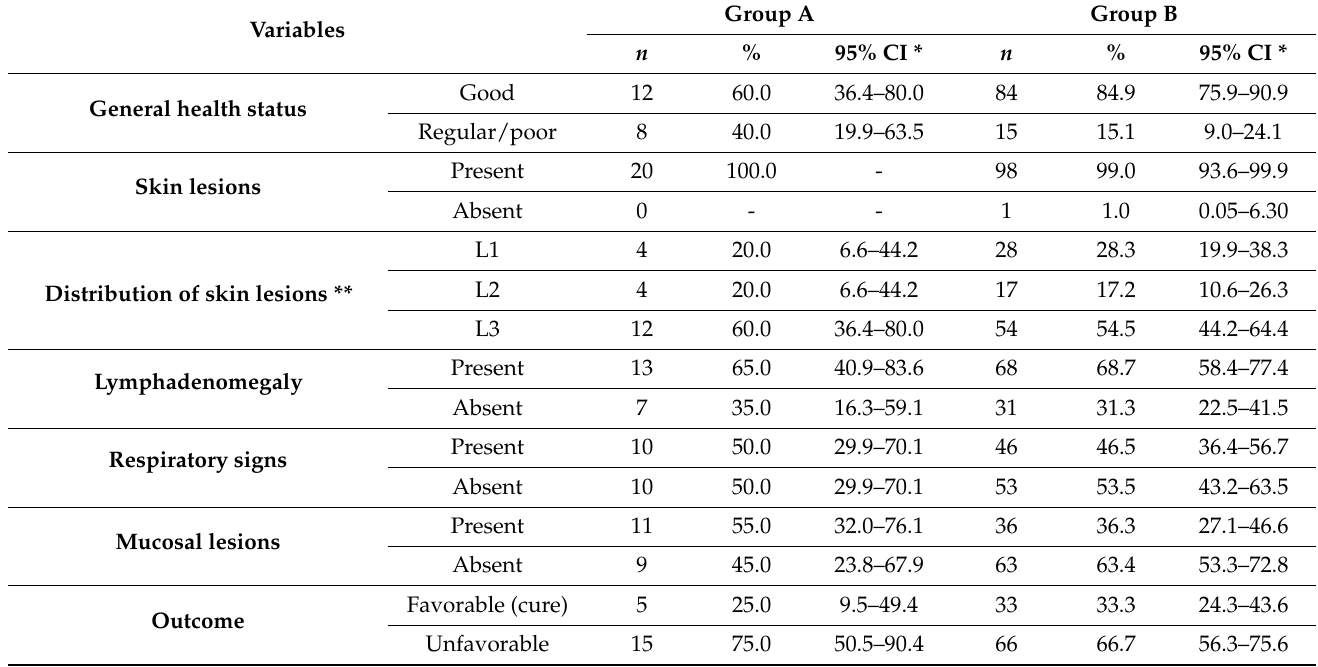
Table 2. Distribution of clinical variables of the 119 cats from which the Sporothrix sp. isolates were obtained between 1998 and 2018 (groups A and B), Rio de Janeiro, Brazil.